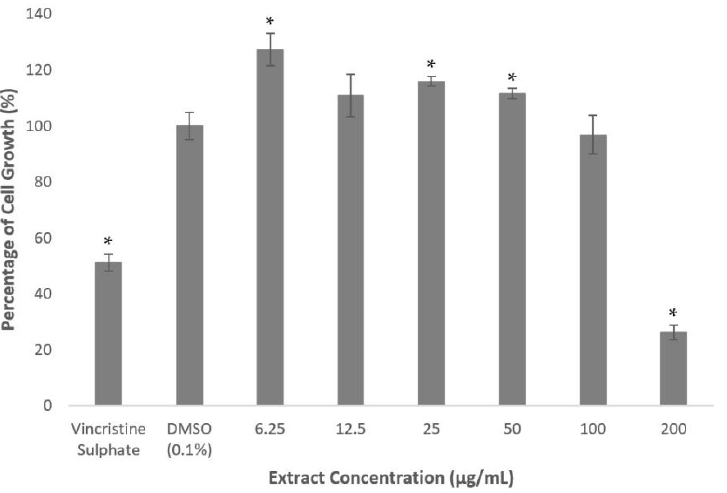
Figure 1. Percentage of cell growth of HepG2 cell line after the treatment of A. planci methanolic extract for 72 h. The cells were treated at various concentrations of the extract from 6.25 to 200 µ g/mL. The value in the untreated control was assigned as 100% and the values in the treated samples were relative to the untreated control value. Data presented as mean ± standard deviation (SD) with n = 6. * denotes significantly different as compared to DMSO-treated cells (negative control) at p < 0.05. DMSO was used as the carrier to dissolve and dilute the